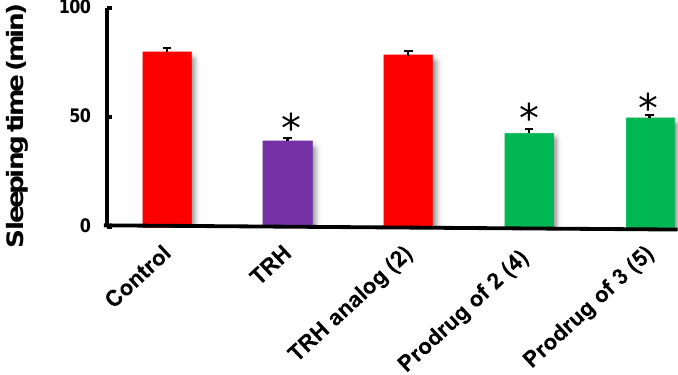
Figure 3. Reversal of pentobarbital-induced sleeping times ( i.e. , analeptic effect) in mice after administration of TRH, TRH analogue 2 and bioprecursor prodrugs 4 and 5 . Sleeping time is expressed as the mean ± SEM ( n = 10 per group). Ten min after i.v. injection of the test compound at a dose of 10 μmol/kg body weight, pentobarbital (60 mg/kg, i.p. ) was injected. Sleeping time was recorded from the onset of the loss of the righting reflex until the reflex was regained. * Statistical significance determined using analysis of variance (ANOVA) followed by post hoc Fisher’s PLSD test for multiple comparisons: p < 0.05 versus vehicle